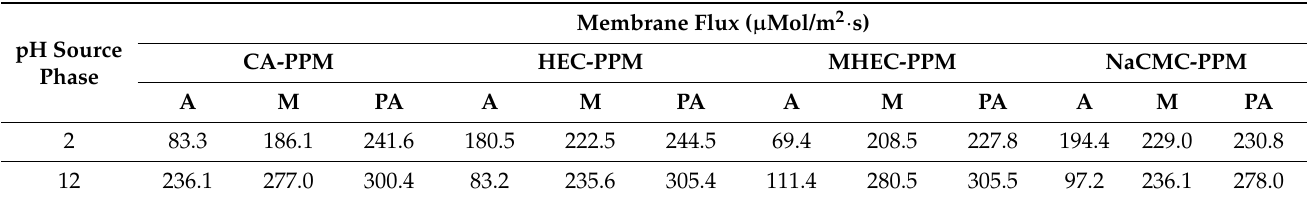
Table 8. The fluxes of the cellulose derivatives membranes at pH = 2 and pH = 12 of the source phase ( A = alanine; M = methionine, and PA = phenylalanine).